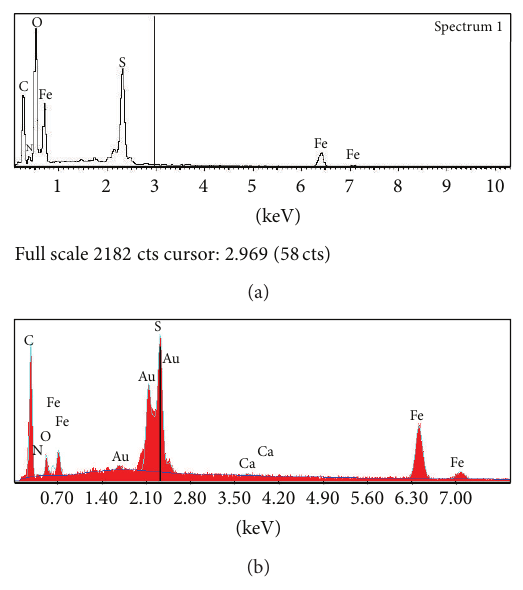
Figure 4: EDS analysis of biofilms for isolated SRB bacteria and ATCC inoculated at 37 ∘ C for 30